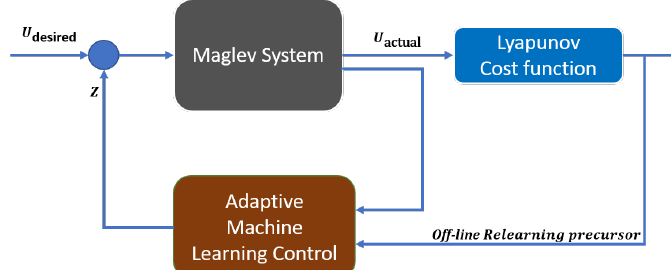
Figure 2. Magnetic levitation system controller setup.